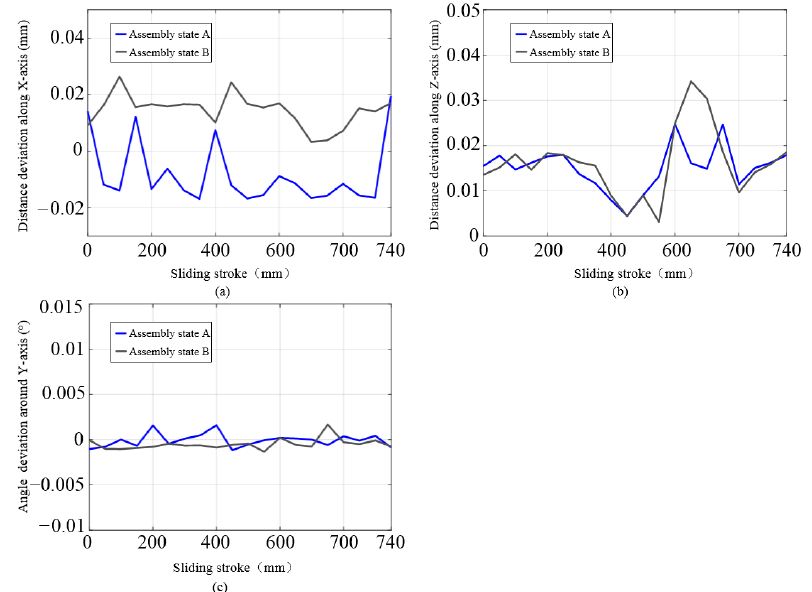
Figure 14. Three types of variation curves. ( a ) Variation curves of the distance deviation along the X ‐ axis, ( b ) Variation curves of the distance deviation along the Z ‐ axis, ( c ) Variation curves of the X-axis, ( b ) Variation curves of the distance deviation along the Z-axis, ( c ) Variation curves of the angle angle deviation around the Y ‐ axis. deviation around the